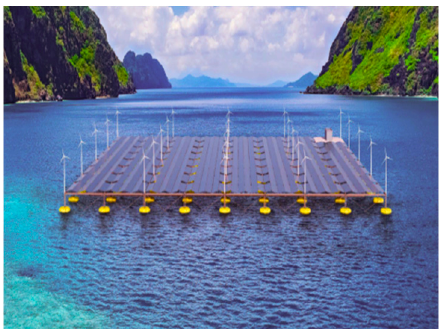
Figure 10. Hybrid offshore platform structure (OHP) [33]. [Permission of using the figure has been requested from the copyright holder SINN POWER].